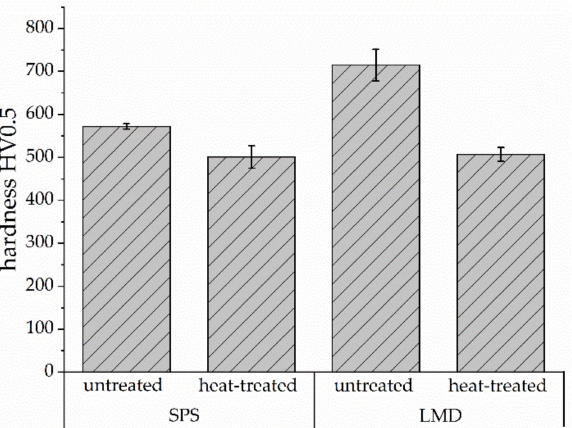
Figure 4. Microhardness of the untreated and heat-treated SPS bulk material and laser metal deposited (LMD) sample Al 0.3 CoCrFeNiNb 0.5 . The highest hardness was detected for the untreated LMD coating. By heat-treating, a hardness decrease was